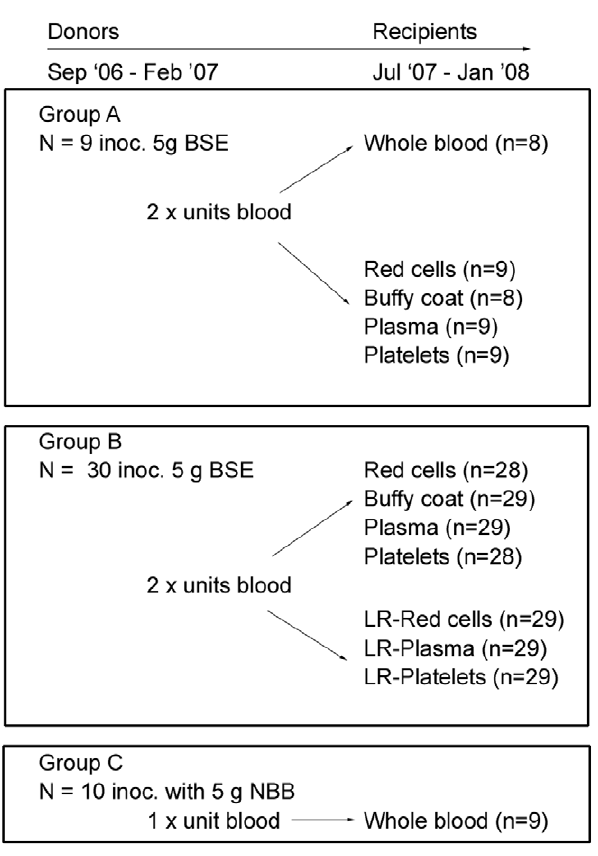
Figure 1. Overview of experimental design. Sheep used as BSE blood donors were divided into two experimental groups (A and B), though both groups were orally inoculated (inoc.) with 5 g of BSE brain homogenate at approximately 3–6 months of age. Two units of blood were collected from all BSE donors and processed according to the experimental regime described: group A sheep - one unit was transfused to recipients as whole blood, whereas blood from the second unit was processed into components and then transfused. Both units of blood from sheep in group B were separated into components and one set of components was passed through human leucoreduction (LR) filters prior to transfusion. Negative control donors (group C), were orally inoculated with normal bovine brain homogenate (NBB). A unit of whole blood was collected from these sheep and transfused to